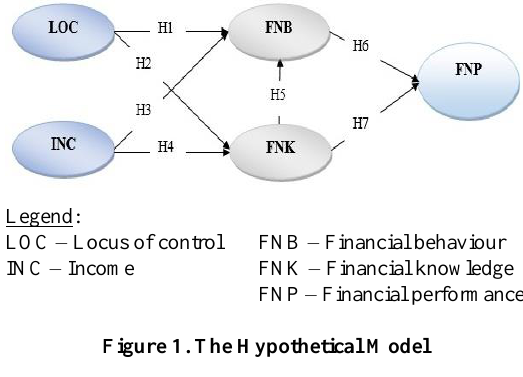
Figure 1. The Hypothetical